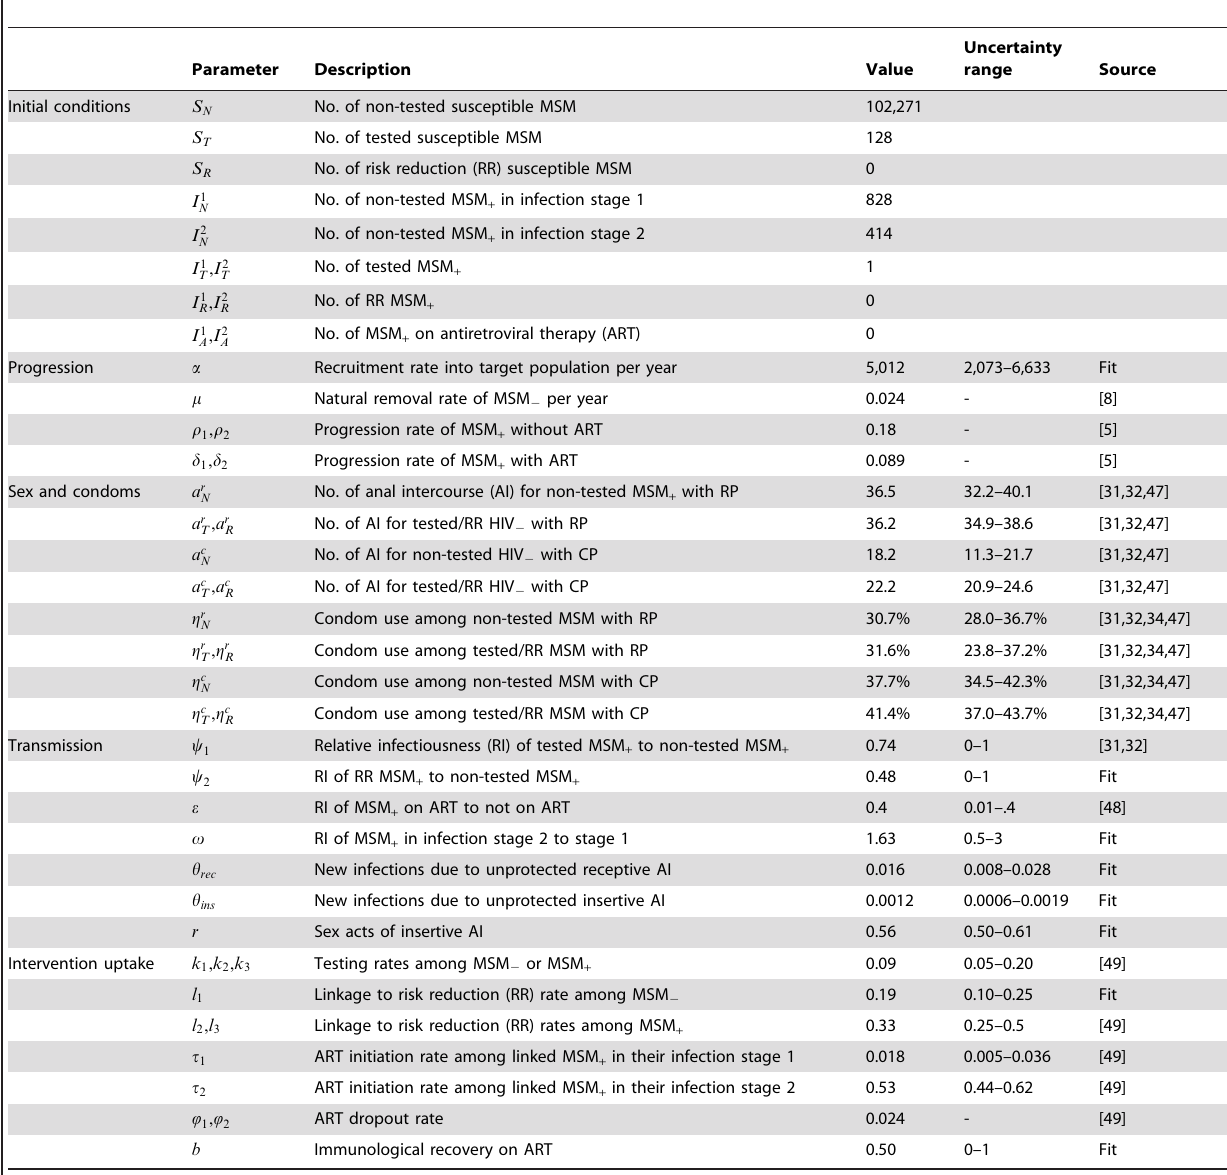
Table 1. The notation, description, value and uncertainty range of parameters and their data sources for the mathematical model.